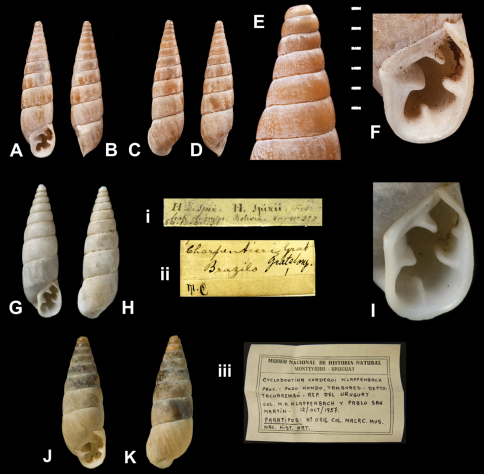
Cyclodontina species. A–F, i
Cyclodontina minor (d’Orbigny, 1837), lectotype NHM 1854.12.4.231 (H = 29.2) E apical whorls (scale equals 5 mm) F detail of aperture G–I, ii
Cyclodontina charpentieri (Pfeiffer, 1850), possible syntype NHM 1975585 (H = 17.9) I detail of aperture J–K, iii
Cyclodontina corderoi Klappenbach, 1958, paratype NHM 1961679 (H = 16.1).